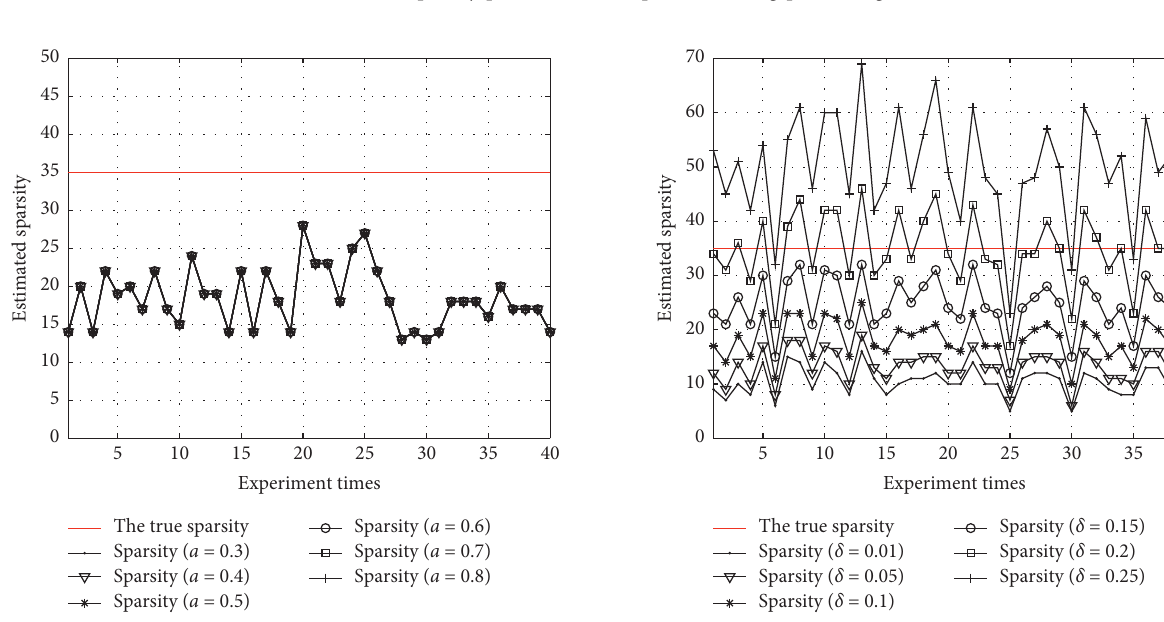
Figure 2: Influence of parameter a on sparsity estimation. Figure 3: Influence of parameter δ on sparsity